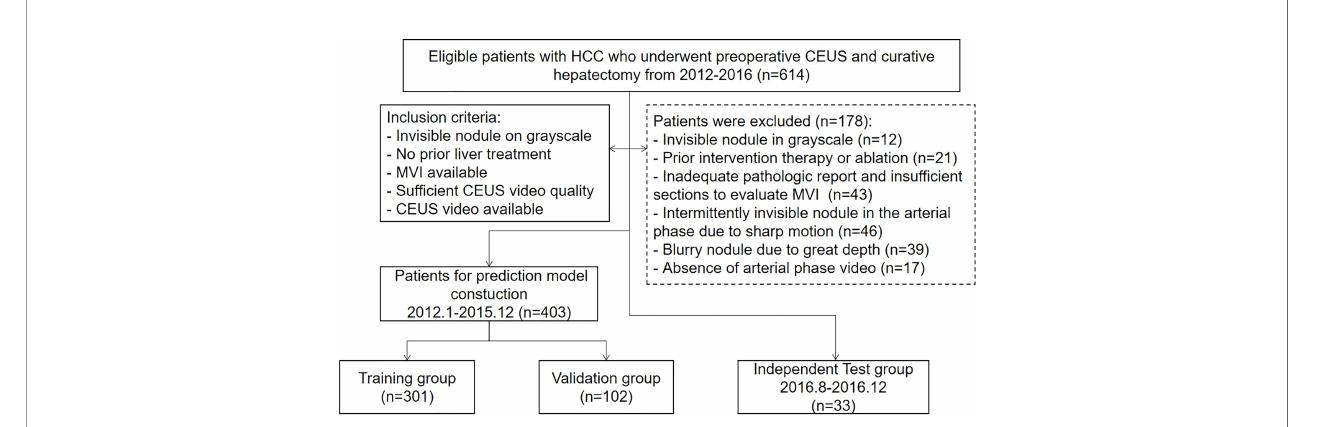
FIGURE 1 | The fl owchart of study group